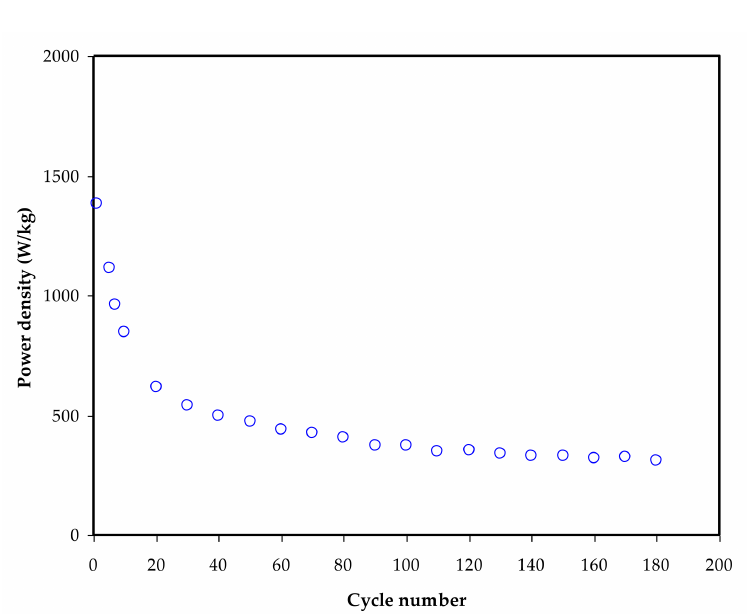
Figure 12. Power density ( P d ) versus cycle number for 180